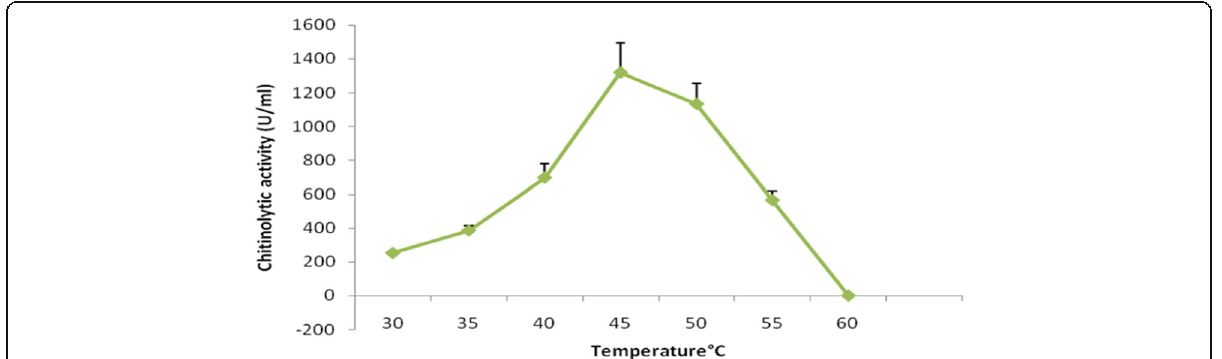
Fig. 6 Effect of incubation temperature on chitinase activity of S . maltophilia JF66, grown at optimized conditions